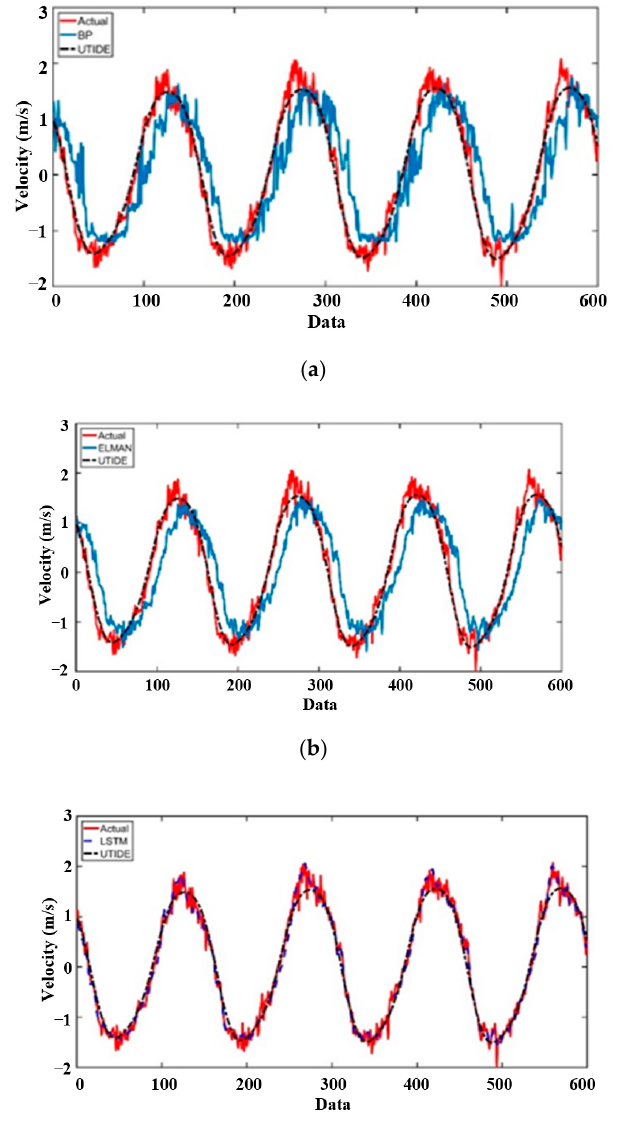
Figure 17. Comparison results of the proposed method by using three machine learning algorithms and UTide (30 m under sea surface). ( a ) Comparison of the BP method, UTide method, and actual value, ( b ) Comparison of the ELMAN method, UTide method, and actual value, ( c ) Comparison of the LSTM method, UTide method, and actual value.